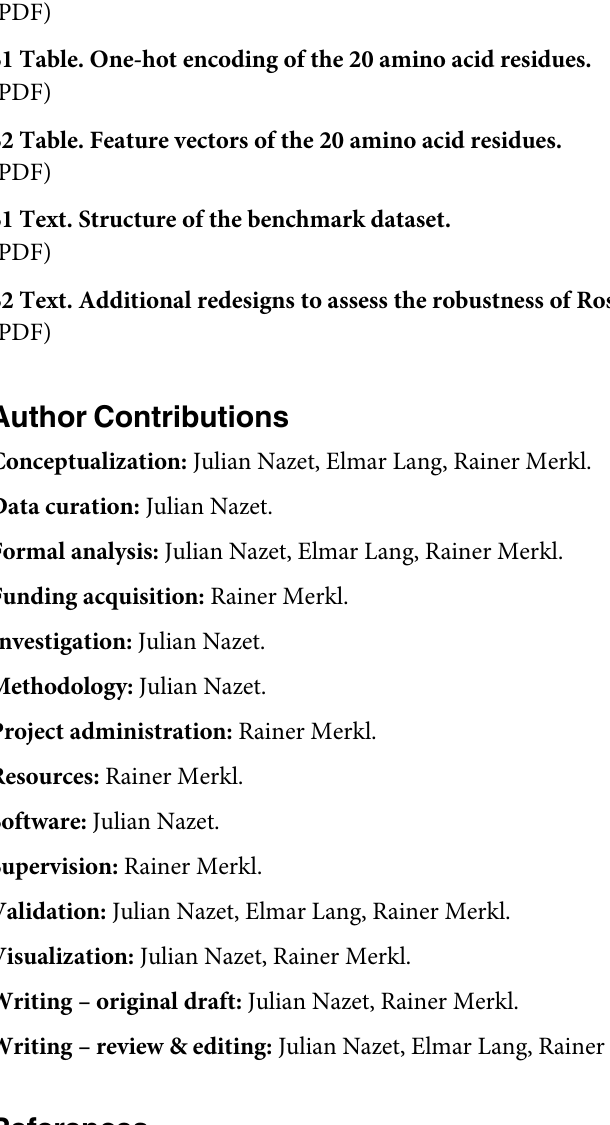
S5 Fig. Design performance with the talaris scoring function. (PDF) S6 Fig. Amino acid frequency distributions for the outcome of the first and second half of design protocols. (PDF) S1 Table. One-hot encoding of the 20 amino acid residues. (PDF) S2 Table. Feature vectors of the 20 amino acid residues. (PDF) S1 Text. Structure of the benchmark dataset. (PDF) S2 Text. Additional redesigns to assess the robustness of Rosetta:MSF:NN.